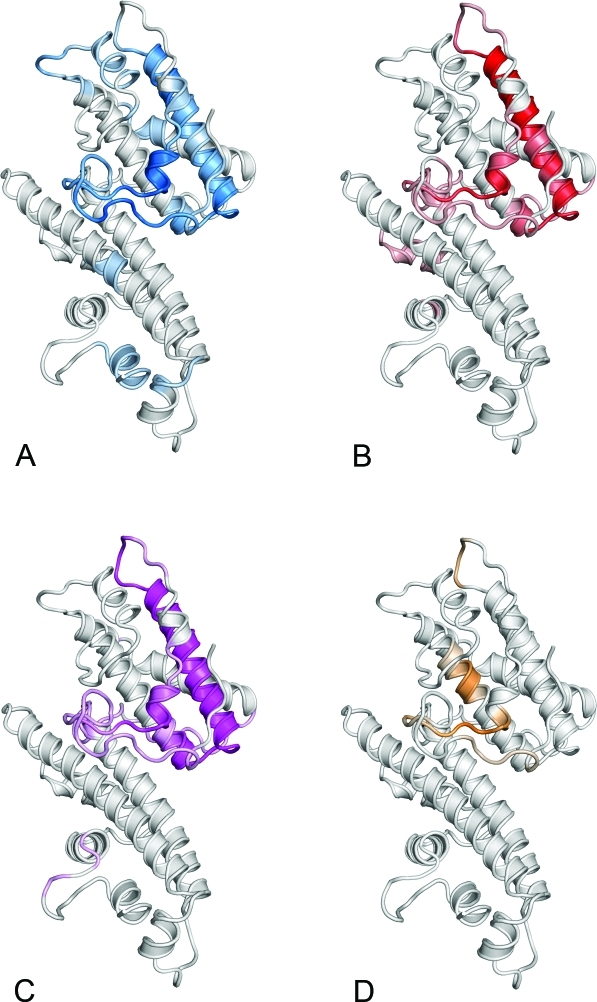
Mapping of Surface-Exposed Antibody-Reactive Regions onto the Model of the DBL6 DomainThe color intensity denotes the level of antibody depletion when VAR2CSA containing plasma is incubated with parasites expressing native VAR2CSA. The following plasma and parasite combinations were used for the depletion experiments.(A) Human plasma pool 1 depleted with 3D7 parasites.(B) Human plasma pool 2 depleted with 3D7 parasites.(C) Human plasma pool 2 depleted with FCR3 parasites.(D) Rabbit plasma pool depleted with 3D7 parasites.